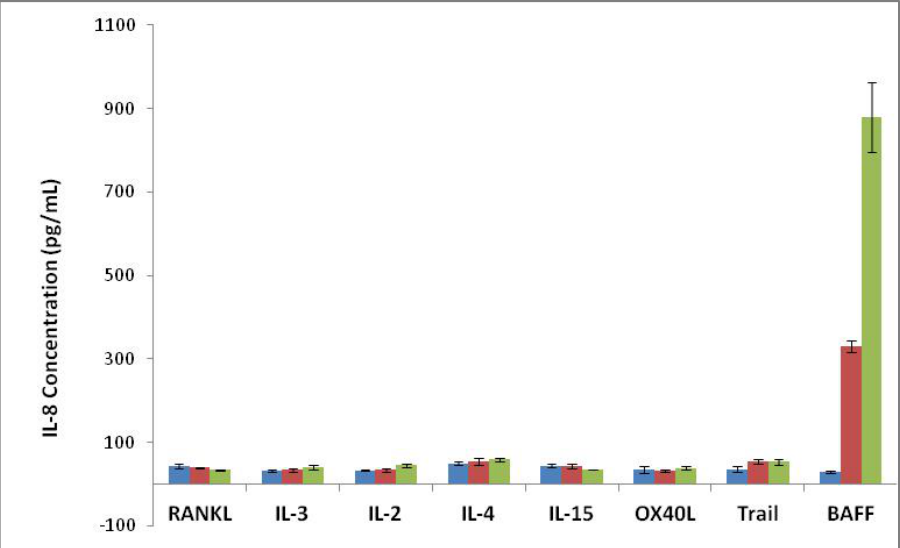
COS-1/B2T.cl.17 cells (green) and COS-1/pCEP4 cells (blue) were incubated